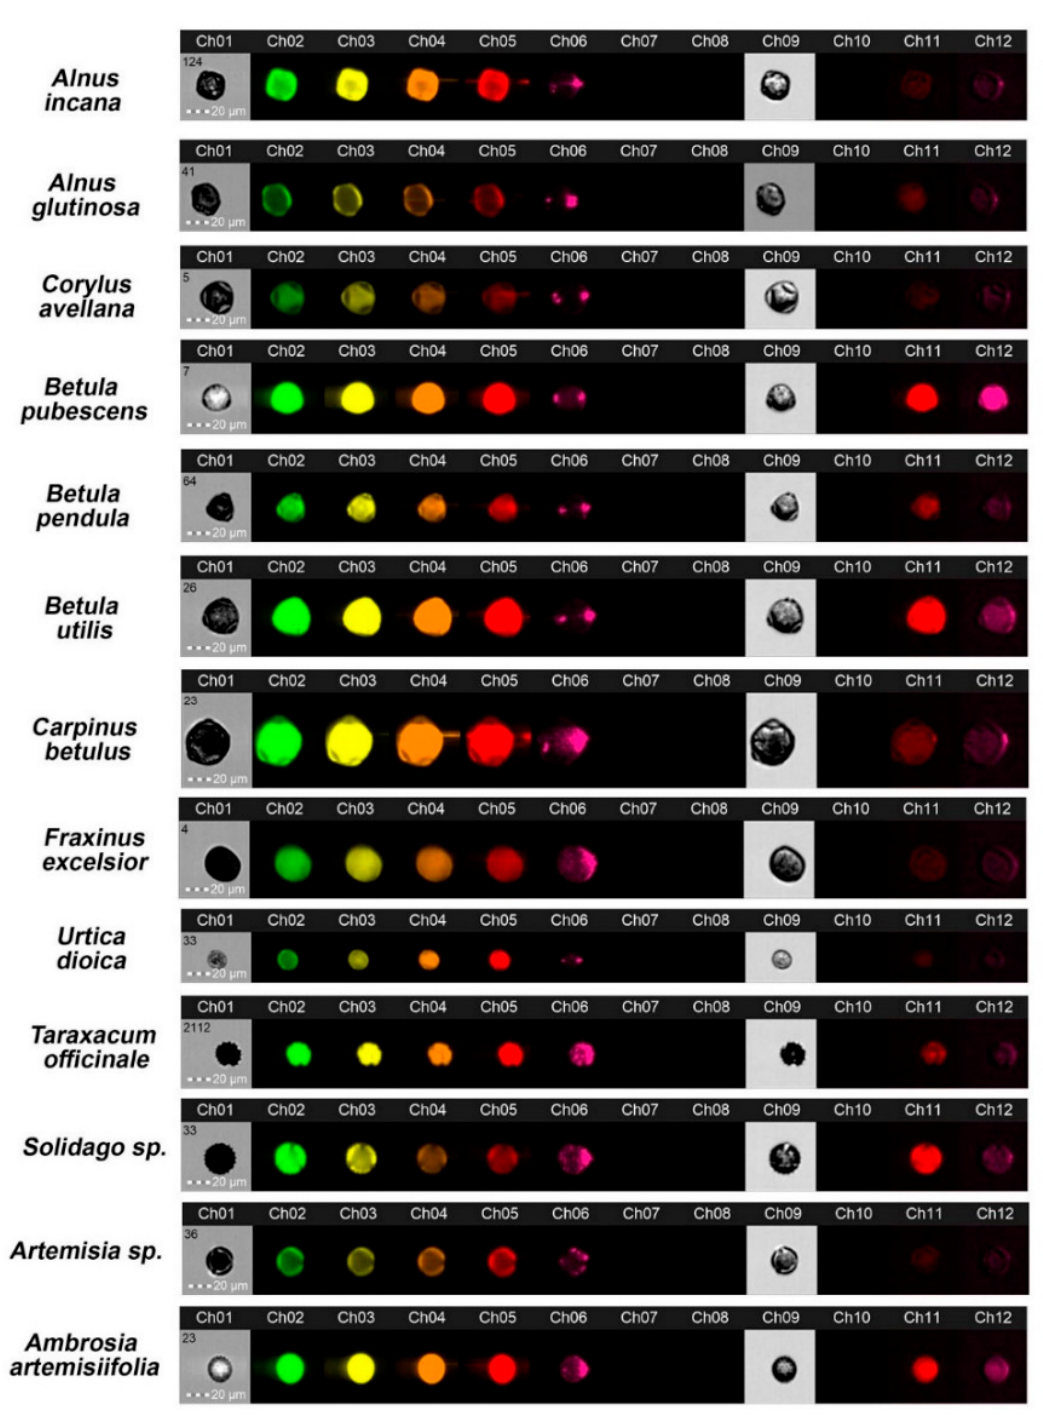
Figure 2. Images of pollen grains examined in individual fluorescent channels taken at ×20 magnification with the imaging flow cytometer.